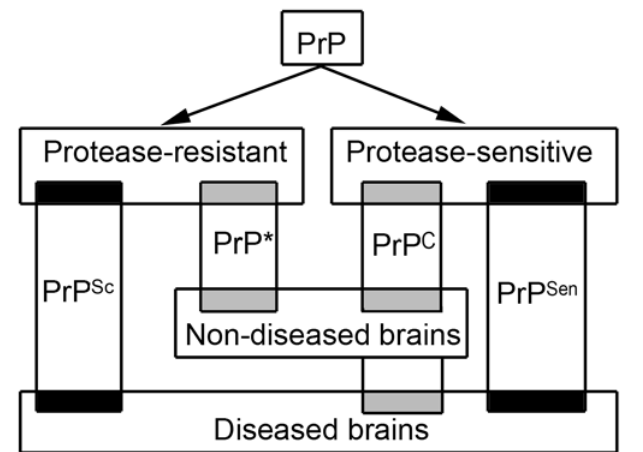
Figure 1. Variability of prion protein (PrP) forms in diseased and non- diseased